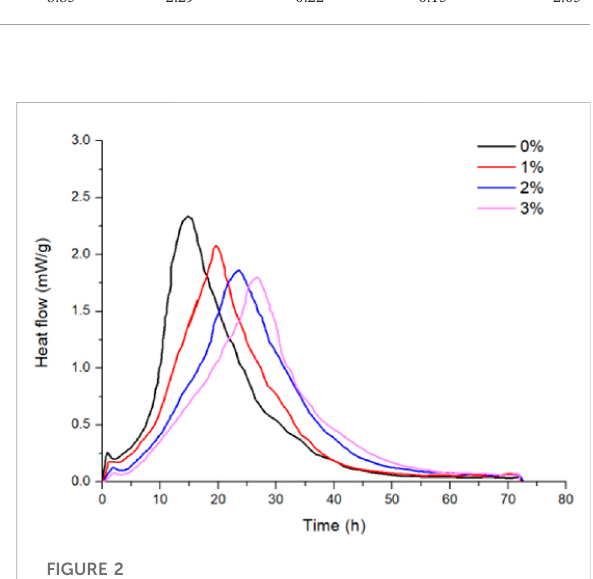
FIGURE 2 Effect of retarder content on heat fl ow of oil well